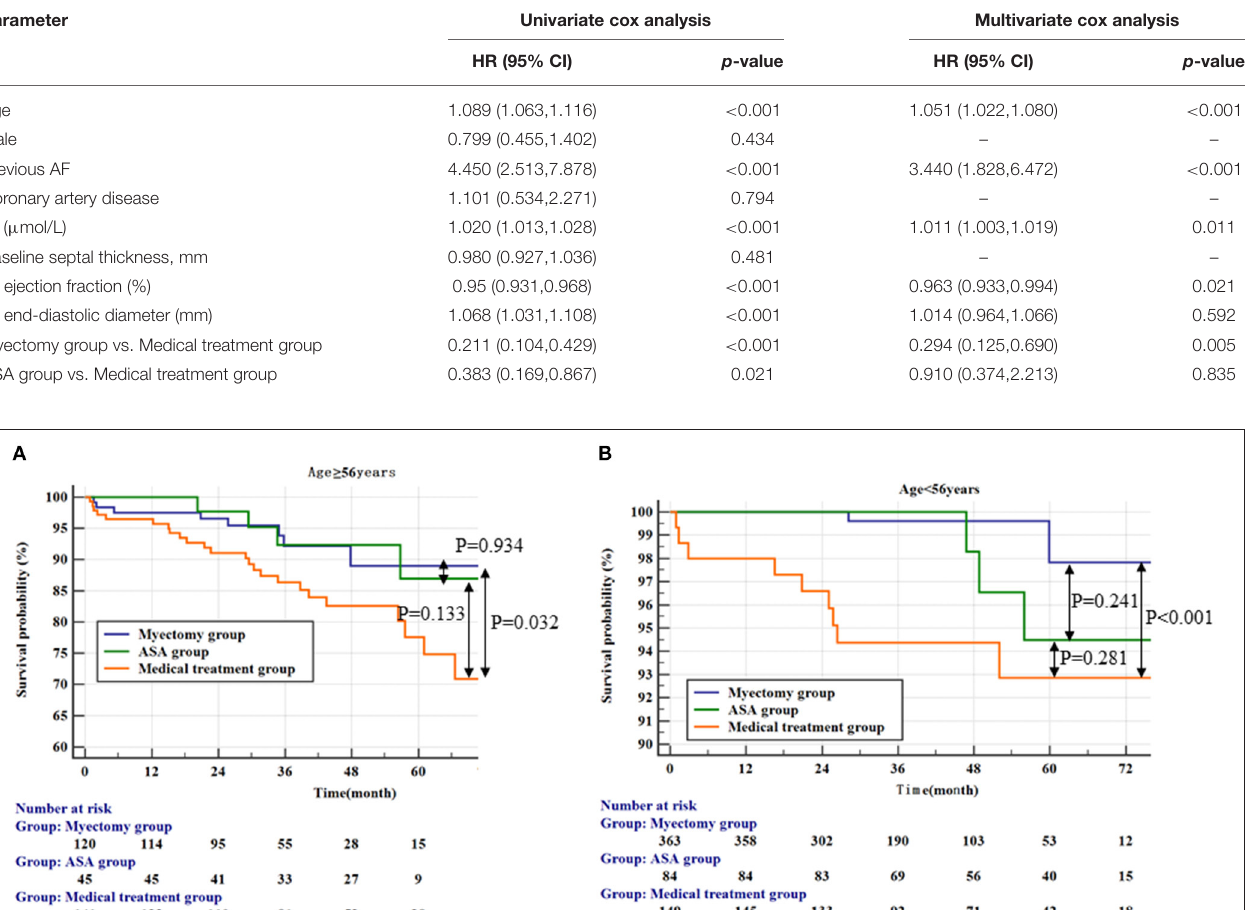
TABLE 4 | Predictors of all-cause mortality and cardiac transplantation.